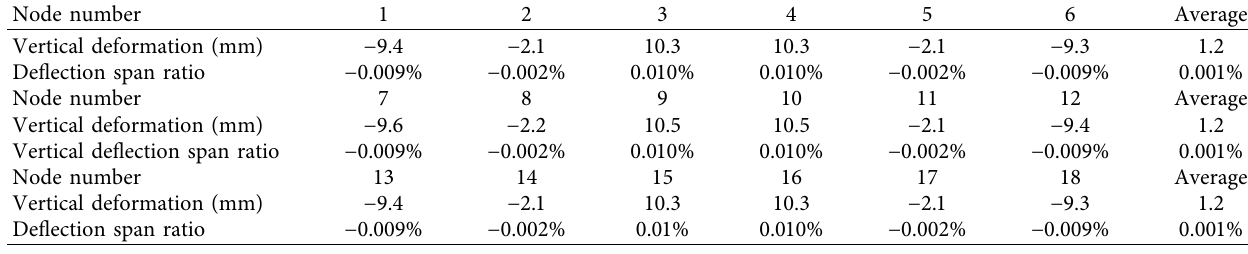
Table 2: Vertical deformation of top nodes of middle struts of one main truss.